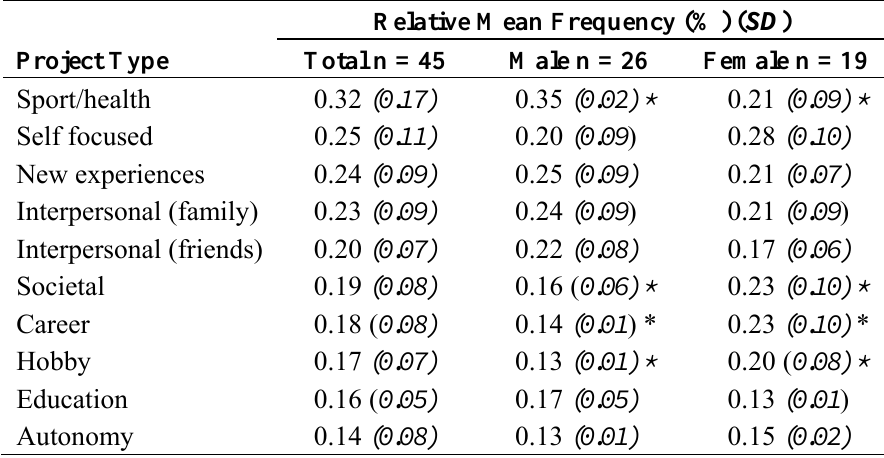
Table 1. Relative frequencies of project